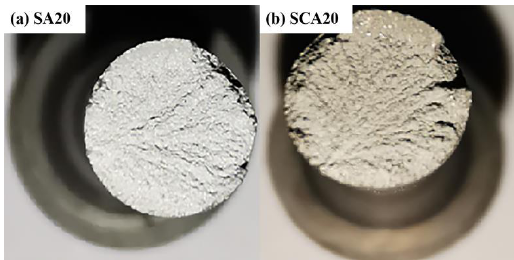
Figure 7. Macro-fracture morphology of the SiCp/2009 aluminum composite, ( a ) SA20 and ( b ) SCA20.